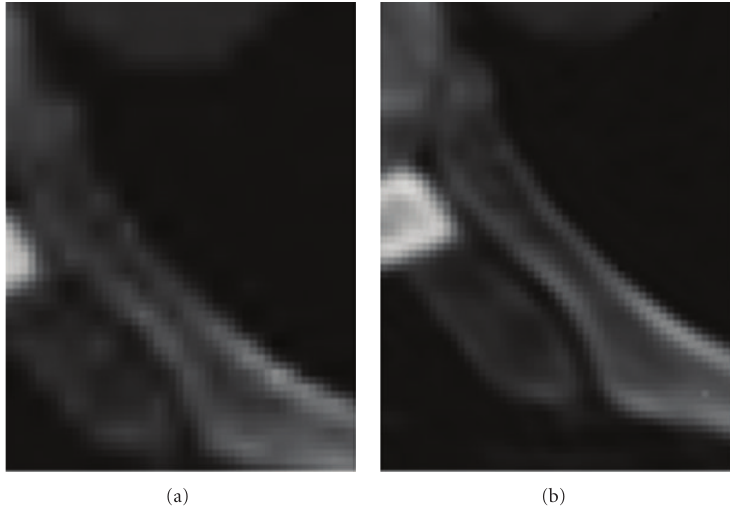
Figure 13: Reconstruction of tomographic data. Wavelet domain (a), and curvelet domain